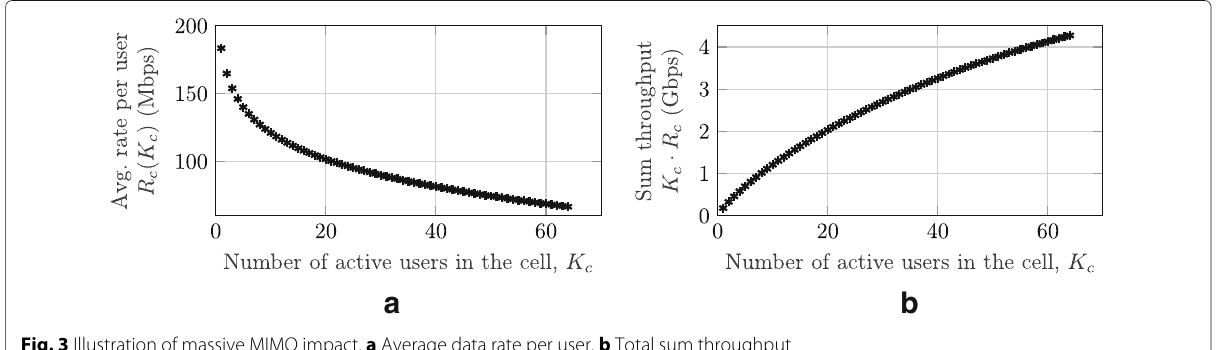
a b Fig. 3 Illustration of massive MIMO impact. a Average data rate per user. b Total sum throughput